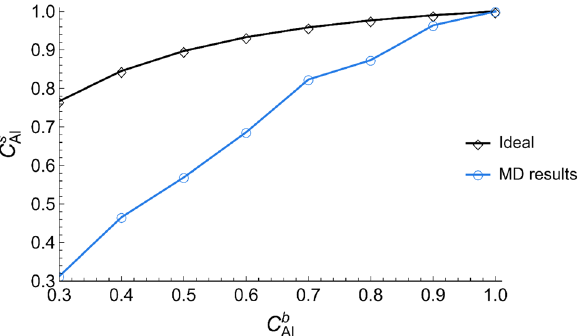
Figure 10. Surface composition of Al–Ni alloys obtained using MD and using the ideal solution